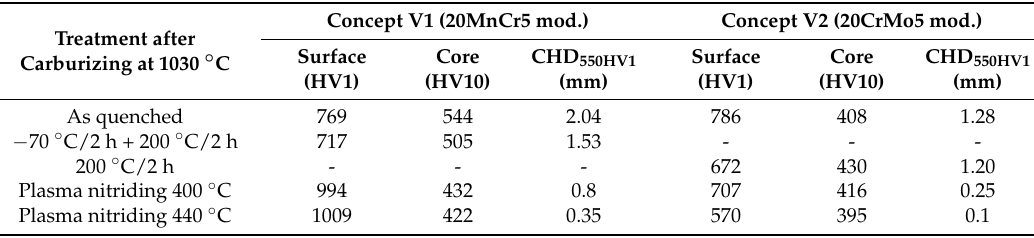
Table 4. Hardness characteristics of steels after various heat